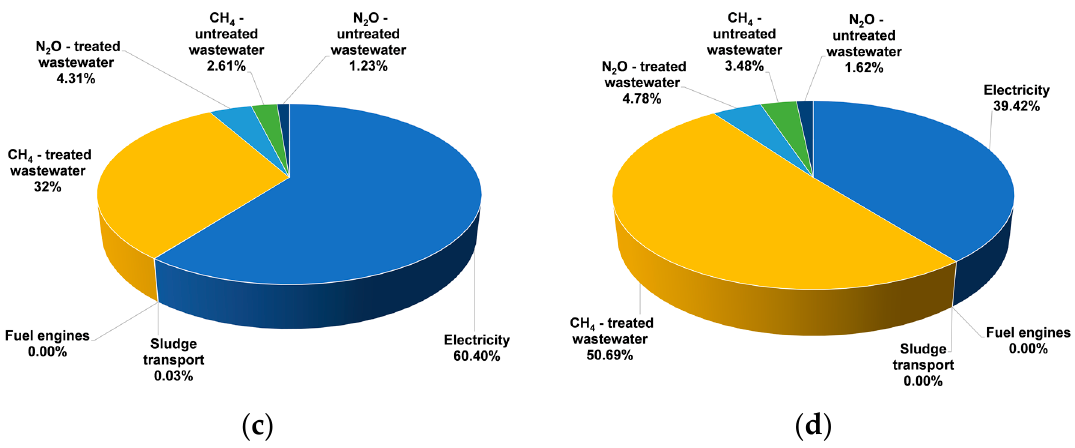
Figure 2. Comparison of GHG emissions of the considered case studies. ( a ) MWWTP A, 25.41 kg CO 2 /year/inhab.; ( b ) MWWTP B, 26.81 kg CO 2 /year/inhab.; ( c ) MWWTP C, 64.32 kg CO 2 /year/inhab.; ( d ) MWWTP D, 68.36 kg CO 2 /year/inhab.